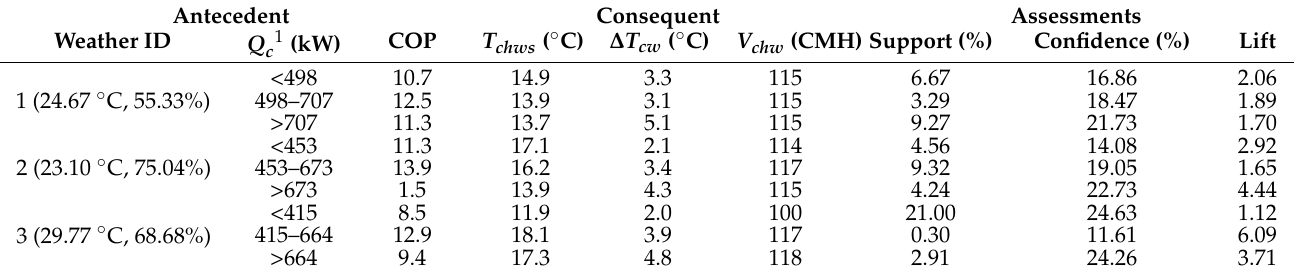
Figure 7. Weather clustering result using k-means algorithm. Table 1. Association rules mining result of optimum operational